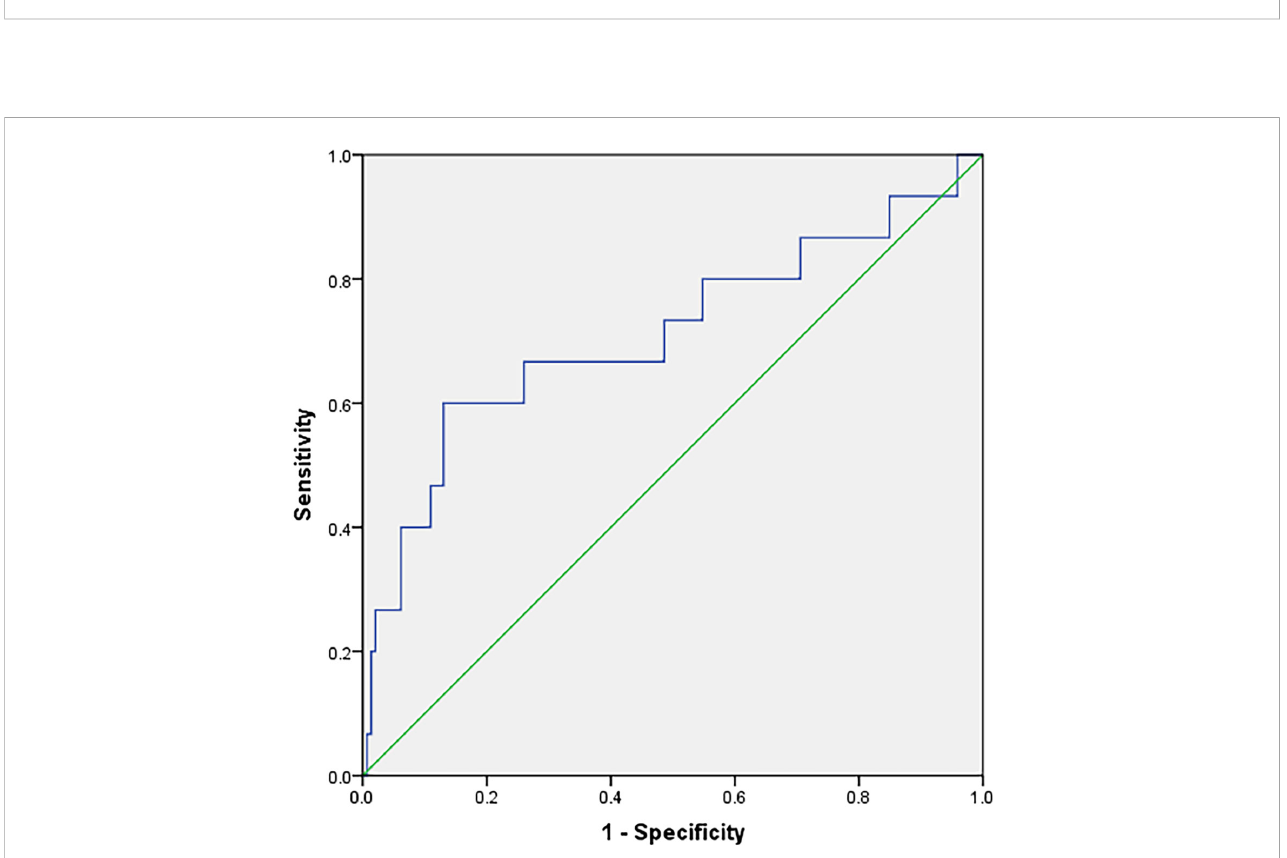
FIGURE 3 Receiver – operating characteristic (ROC) curve analysis for the b -CTX as a predictor of osteoporosis in postmenopausal females with T2DM (The sensitivity and speci fi city were 60.0% and 13.0%,